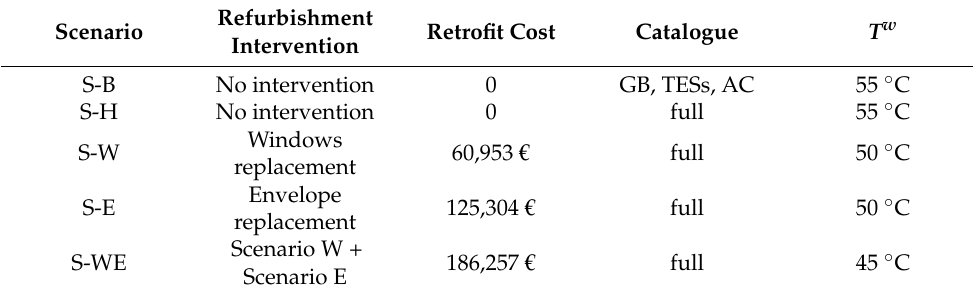
Table 5. Description of considered